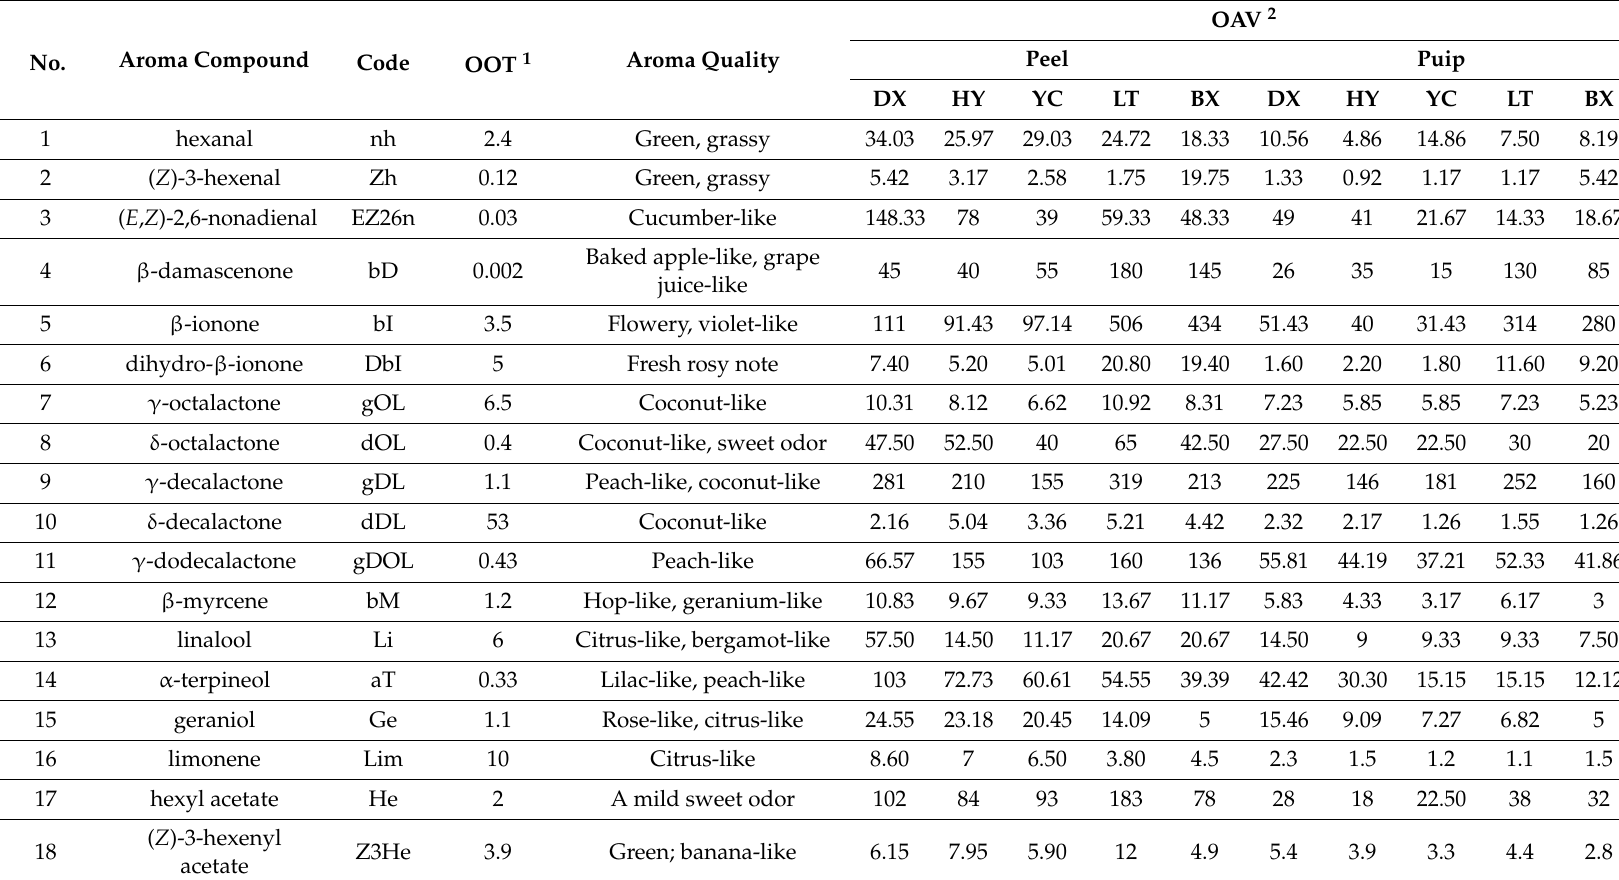
Table 2. Orthonasal odor thresholds (OOT) and odor activity values (OAV) of apricot aroma